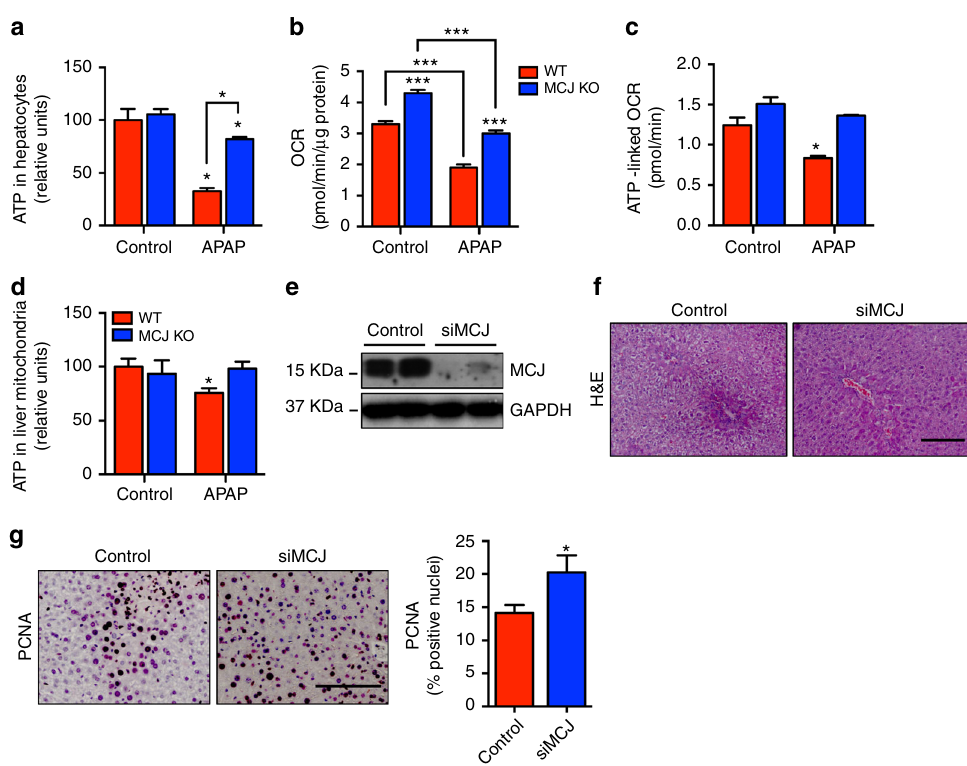
Fig. 4 Lack of MCJ counteracts APAP toxicity in hepatocytes by maintaining mitochondrial function and ATP levels. Triplicates were used for experimental condition. a Total ATP levels in WT and MCJ KO primary hepatocytes treated with APAP for 9 h. b Oxygen consumption rate (OCR) and c mitochondrial ATP production using the Mitostress assay at basal conditions and in the presence of APAP in WT and MCJ KO primary hepatocytes. d ATP levels in mitochondria isolated from WT and MCJ KO livers after 24 h of APAP administration. e – g WT mice were administered with APAP 360 mg/kg ( n = 12), 24 h later mice ( n = 4) received siMCJ and 12 h later mice were harvested and livers were used to examine e MCJ silencing by western blotting, f liver necrosis by H&E staining, and g PCNA expression by immunohistochemistry. Scale bar corresponds to 100 μ m. Values are represented as mean ± SEM. * P < 0.05,